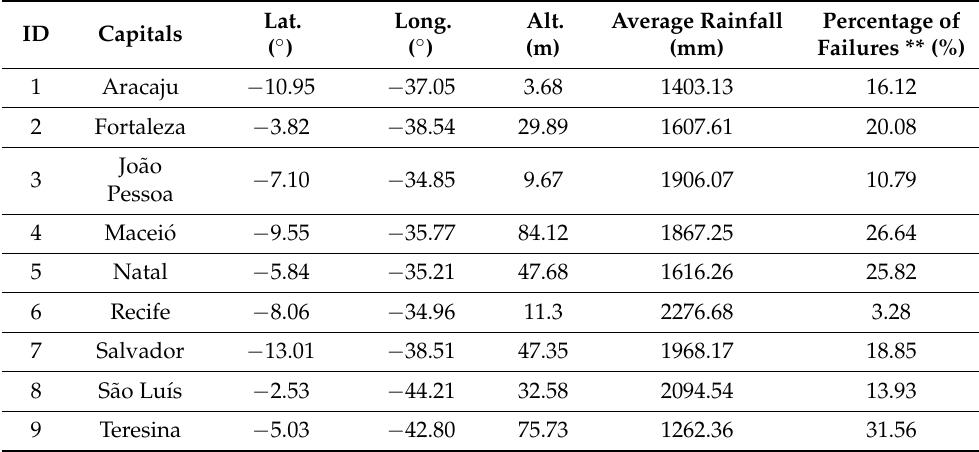
Table 2. The detail about the parameters from 9 different